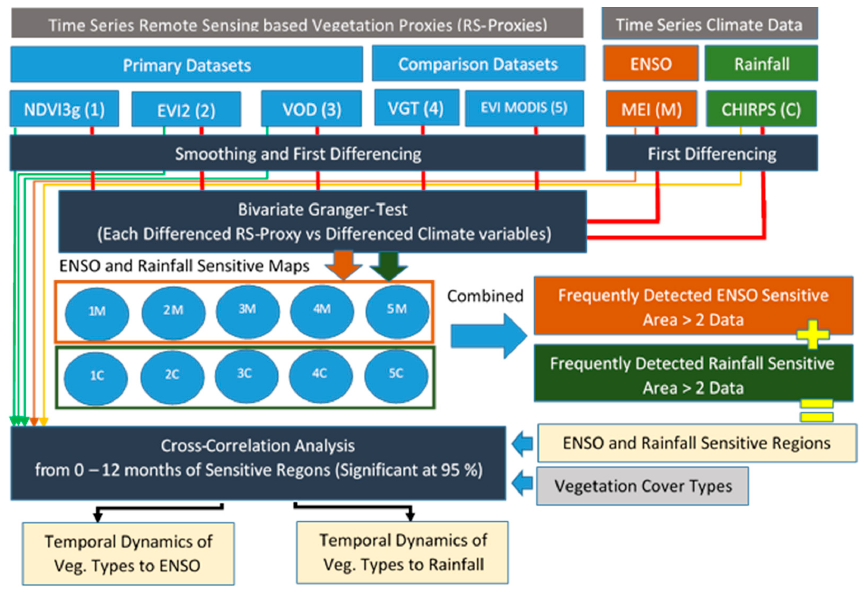
Figure 3. Processing workflow to identify the ENSO- and rainfall-sensitive regions and temporal dynamics.